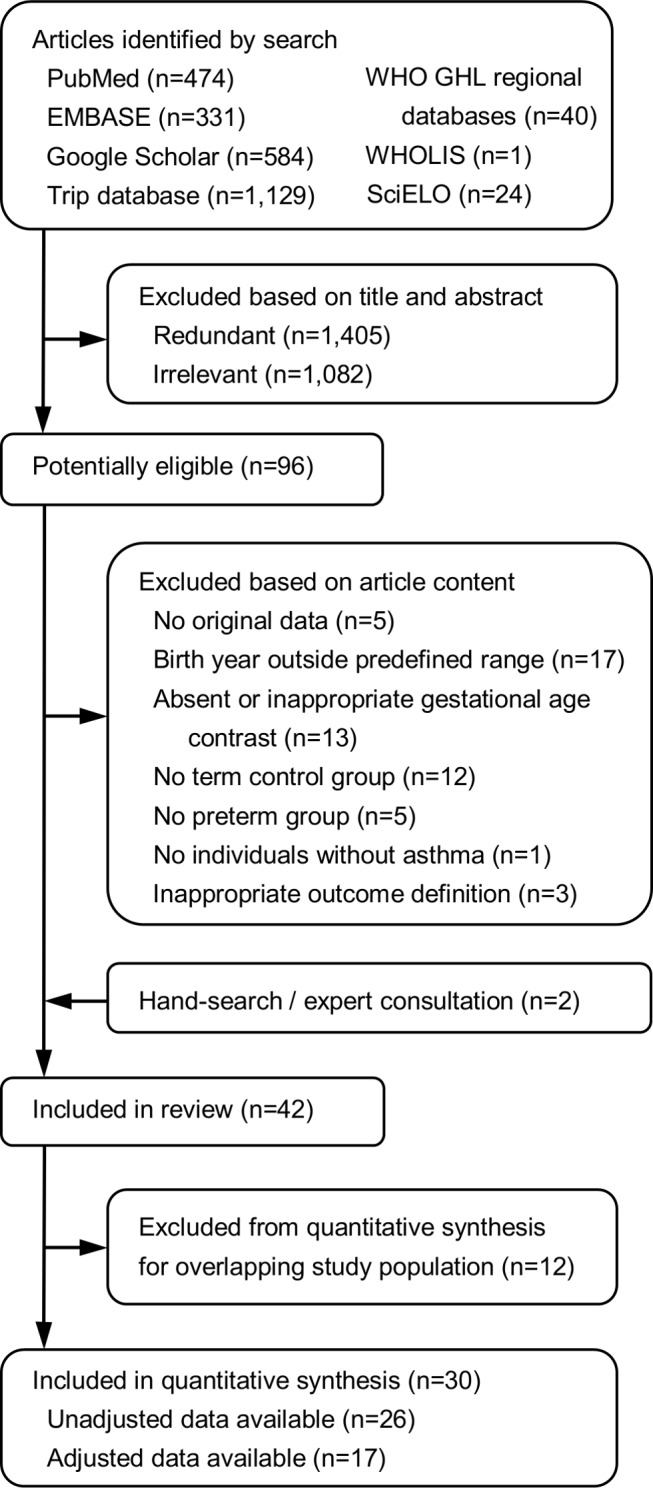
Flowchart outlining study selection.WHO GHL, World Health Organization Global Health Library; WHOLIS, World Health Organization Library Information System.